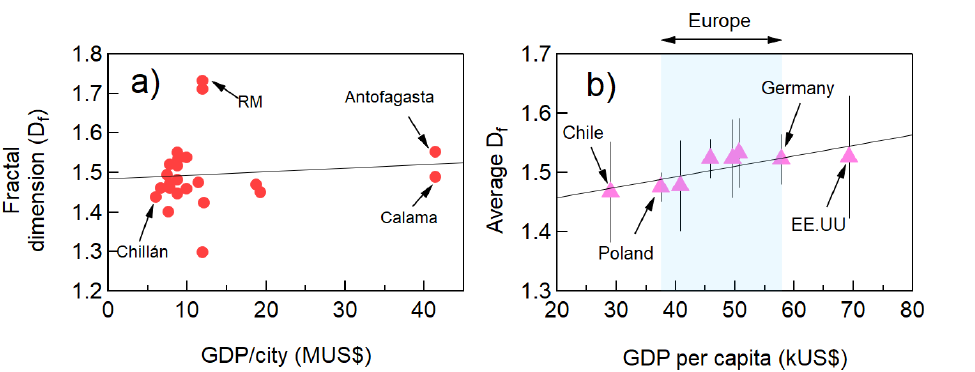
Figure 10. D f versus the Gross Domestic Product ( GDP ) at ( a ) regional level and ( b ) by country (the parameter ¯ D 2 was used for these